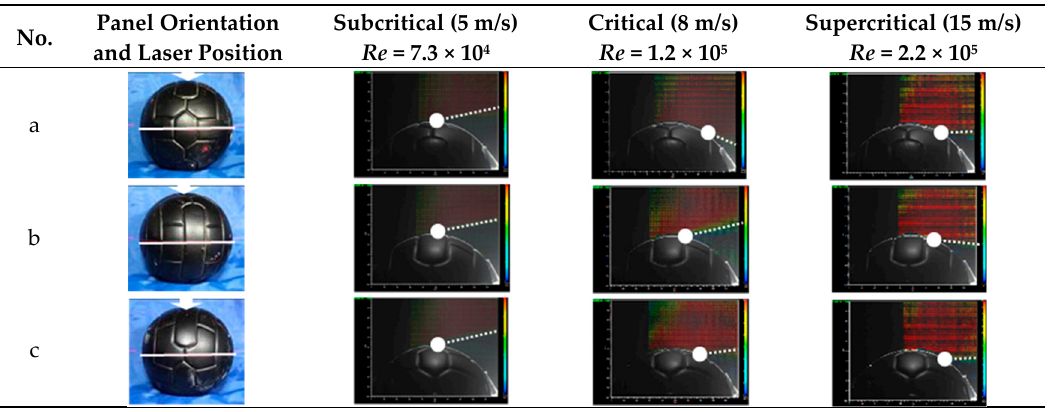
Table 3. The PIV results of the Vantaggio with different panel orientations and different flow aspects.